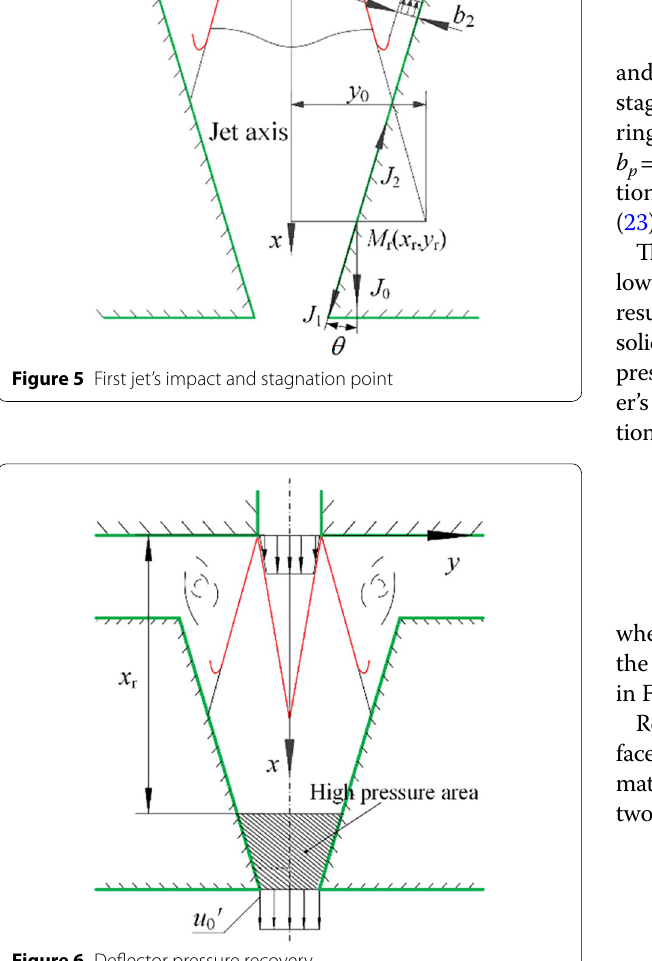
Figure 6 Deflector pressure